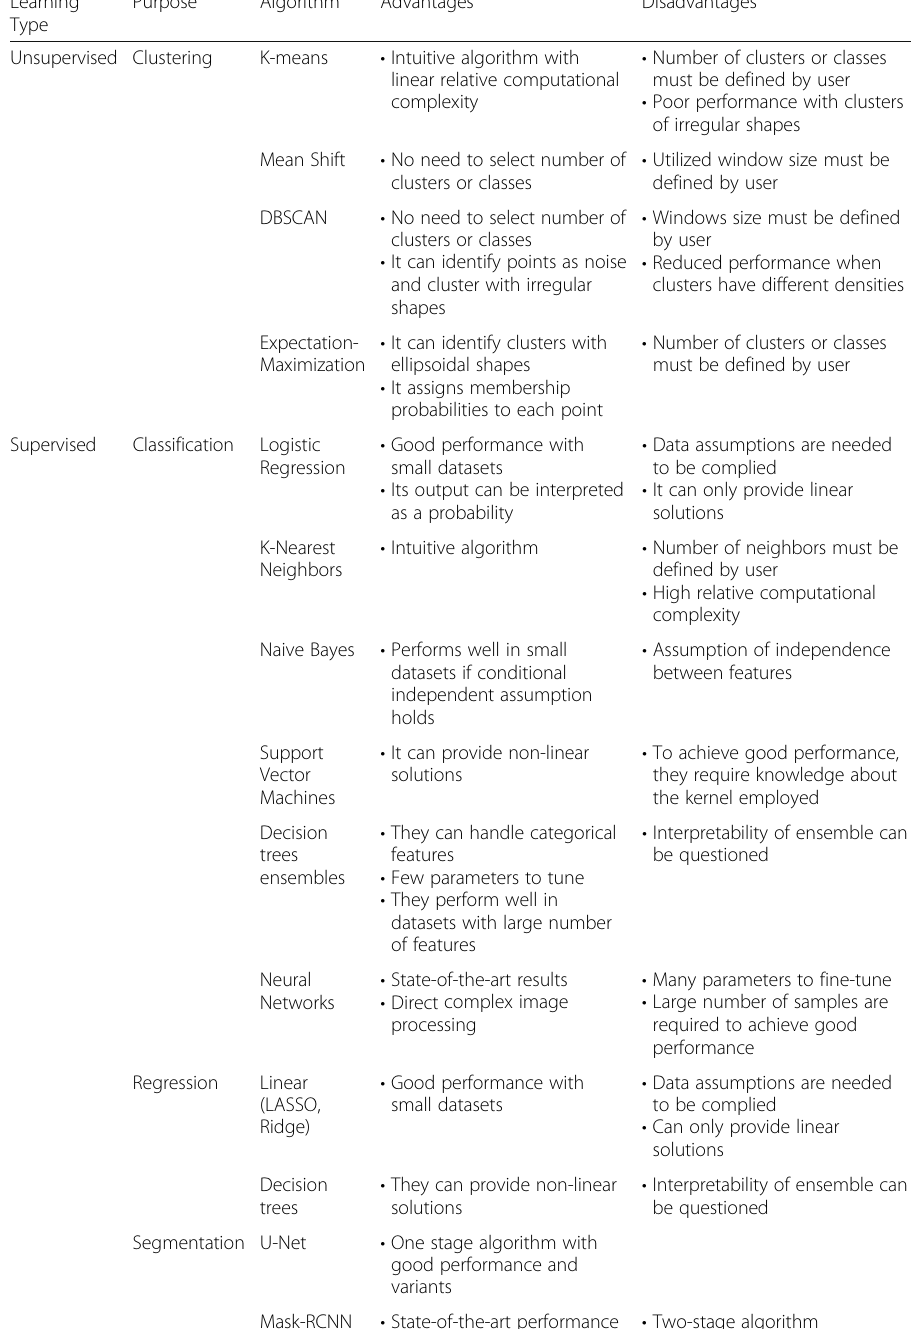
Table 1 Overview of advantages and disadvantages of commonly utilized machine learning algorithm clustered by utilized type of